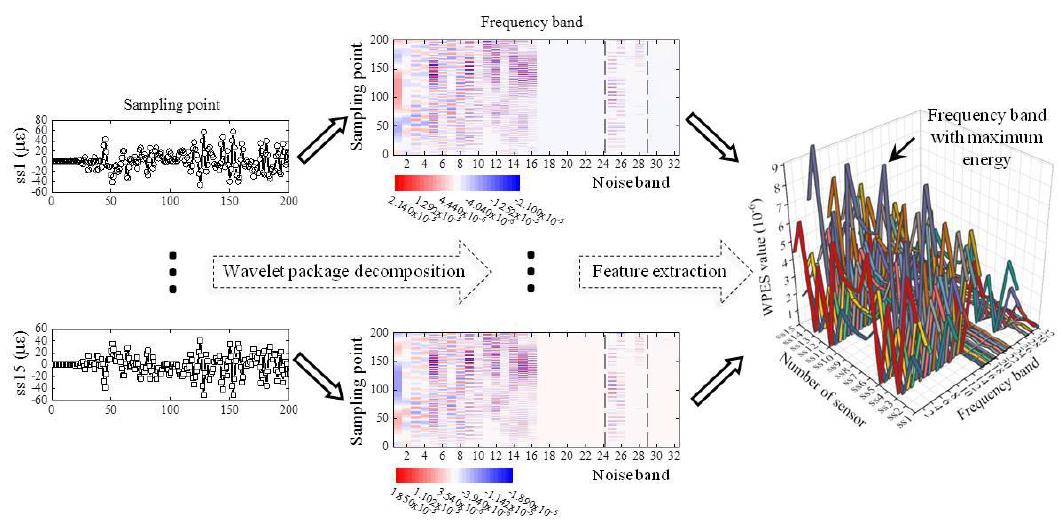
Figure 6. Example of WPES feature extraction of a data segment (200 sampling points from the first sliding time window of all the strain channels).